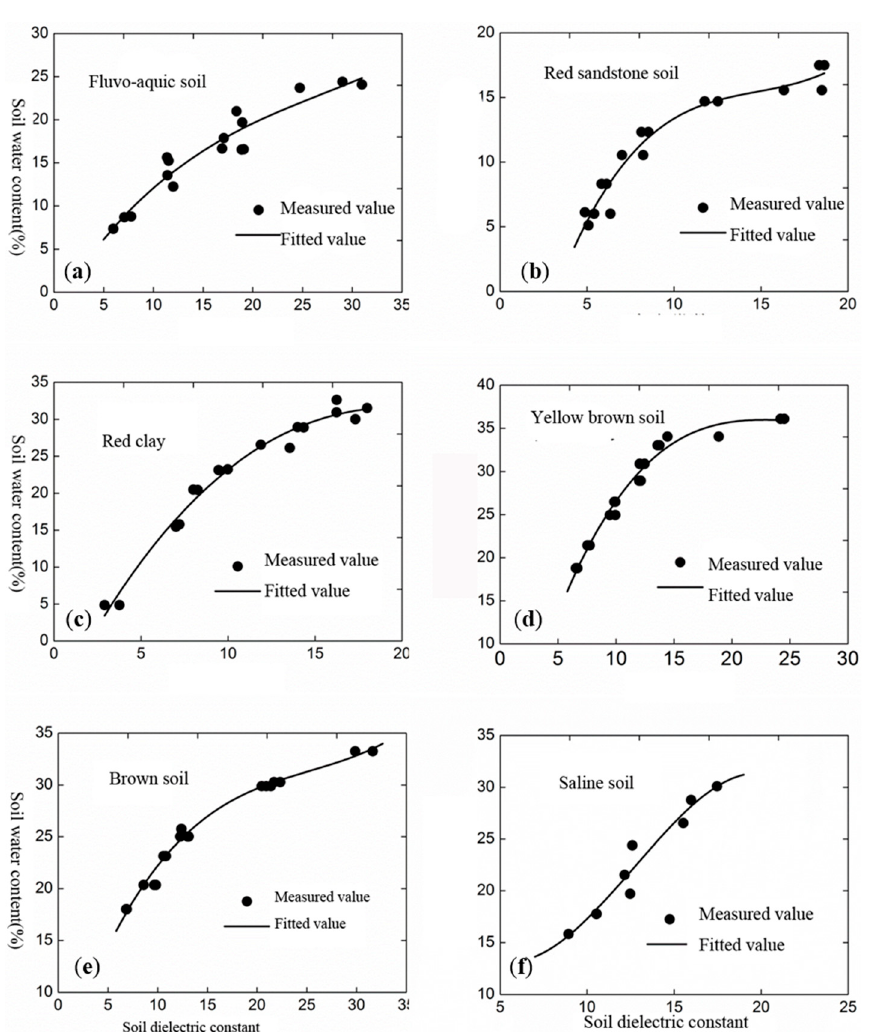
Figure 6. Fitted curves between the soil dielectric constant and SWC. ( a ) fluvo-aquic soil; ( b ) red sandstone soil; ( c ) red clay; ( d ) yellow brown soil; ( e ) brown soil; ( f ) saline soil.